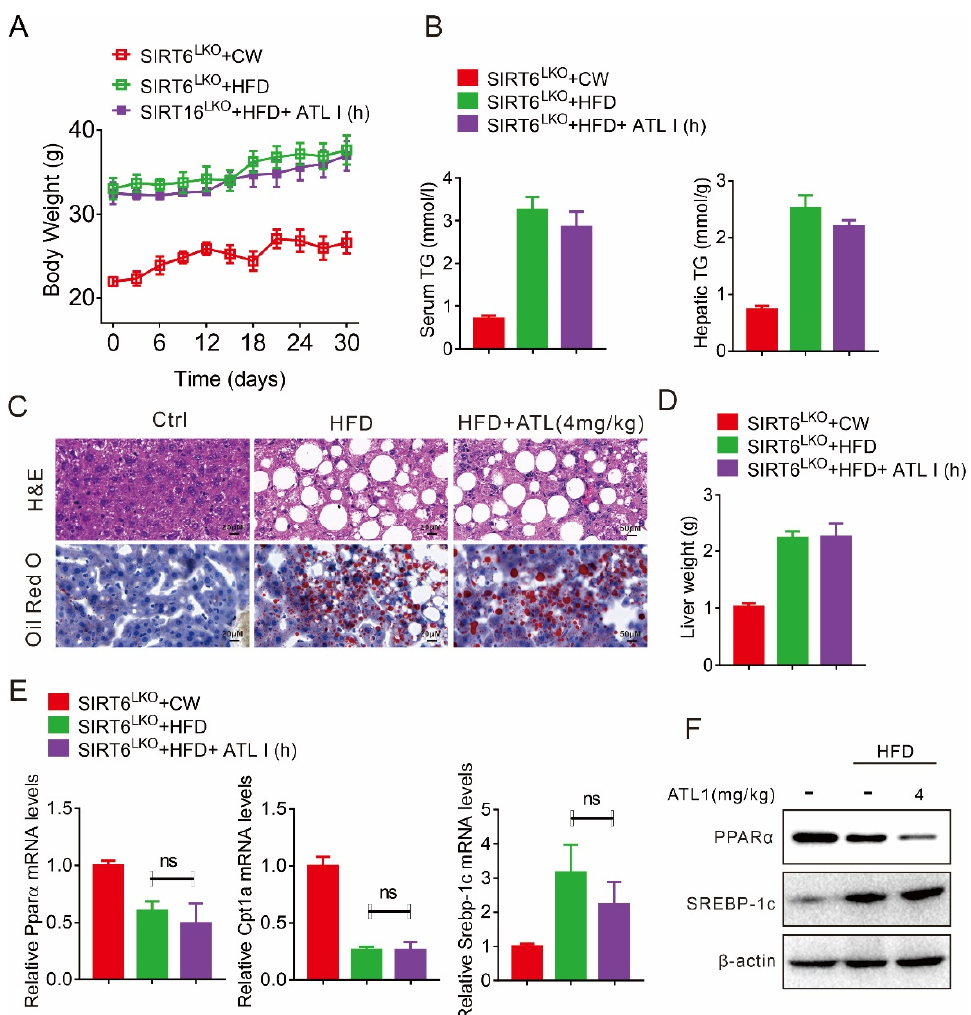
Figure 6. ATL I treatment failed to alter HFD-induced fatty liver in hepatic SIRT6 knockout mice. ( A ) ATL I treatment did not change the body weight of hepatic SIRT6 knockout mice fed an HFD. ( B ) ATL I treatment failed to change the TG levels in the serum and livers of hepatic SIRT6 knockout mice fed an HFD. ( C ) H&E and oil red O staining data indicated that ATL I treatment failed to change the fatty liver phenotype and lipid accumulation in hepatic SIRT6 knockout mice fed an HFD. ( D ) ATL I treatment did not change the liver weight of hepatic SIRT6 knockout mice fed an HFD. ( E , F ) ATL I treatment failed to alter the mRNA ( E ) and protein ( F ) levels of genes related to lipid metabolism in hepatic SIRT6 knockout mice fed an HFD. Results are shown as mean ± SEM (n ≥ 4).